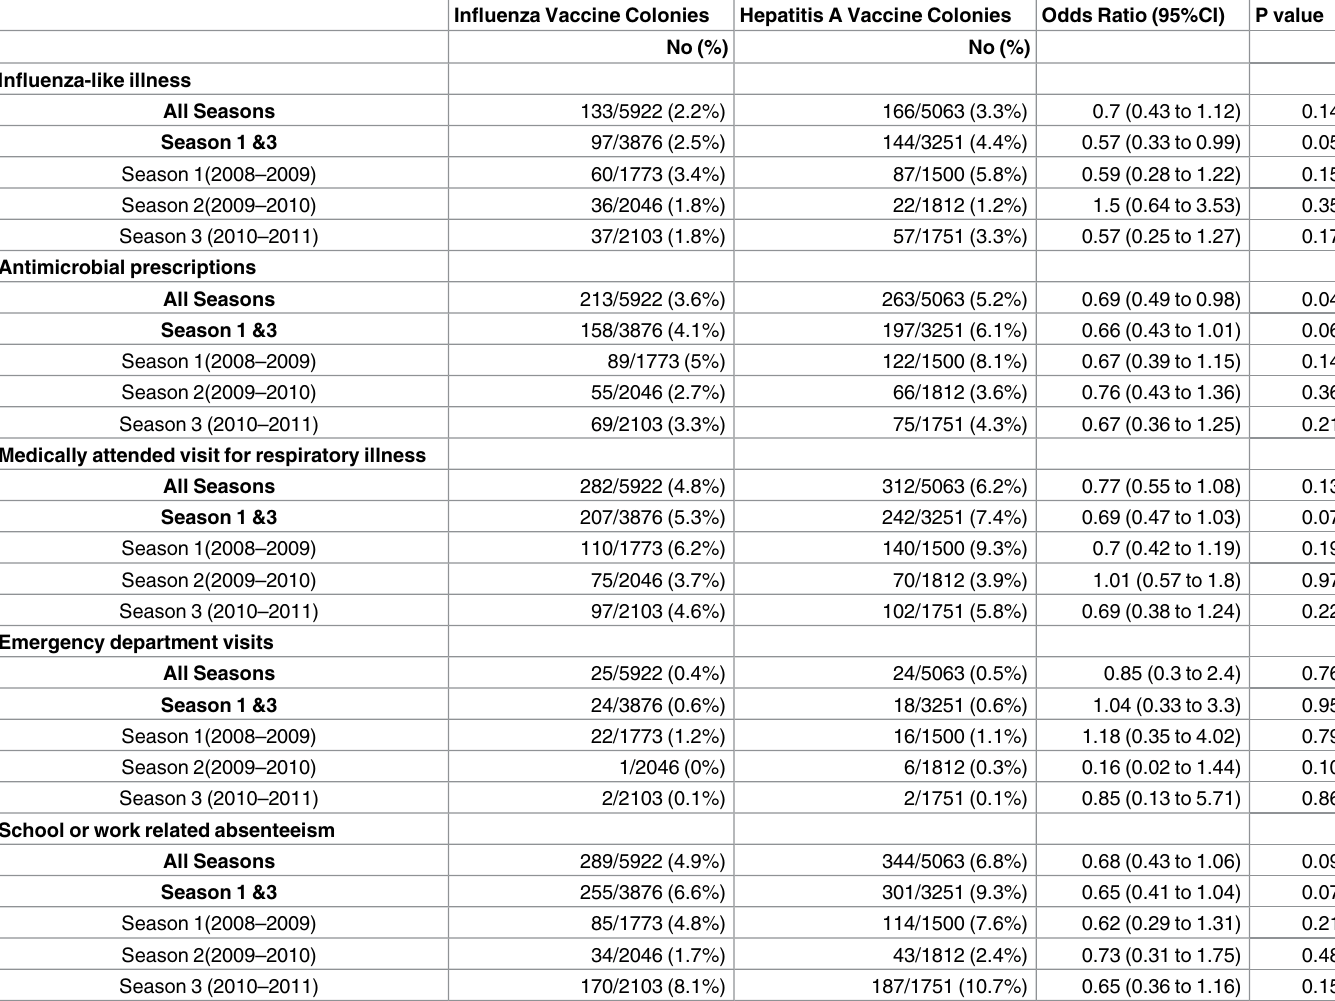
Table 5. Association of secondary outcomes in all participants a